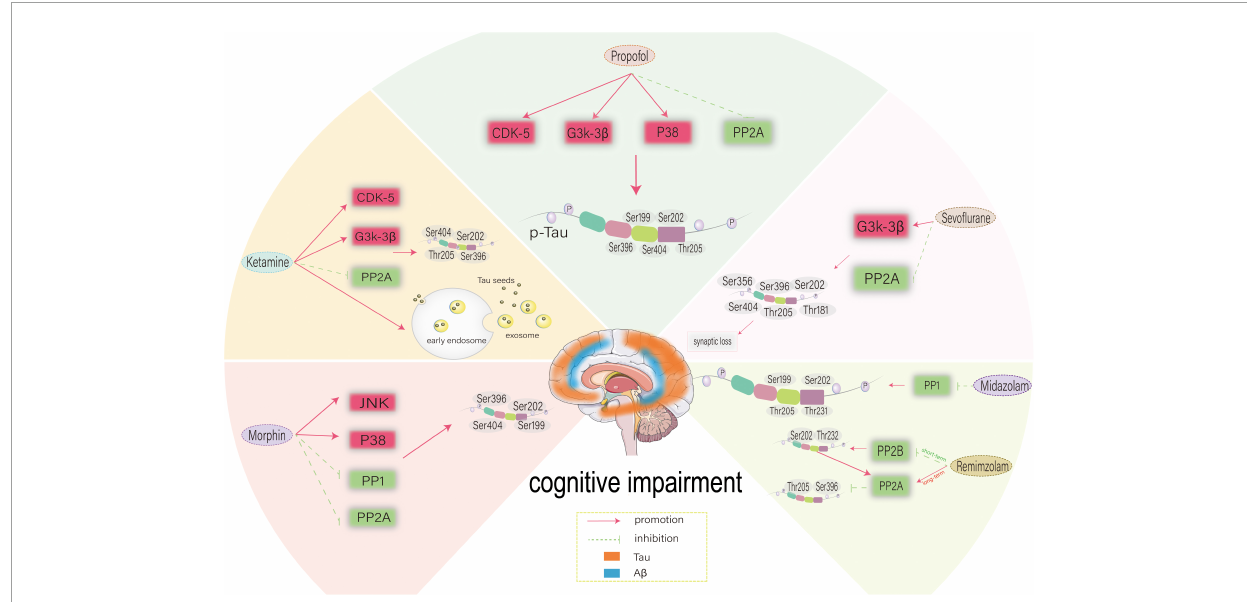
FIGURE3 Possible mechanism of different anesthetic drugs-induced-Tau phosphorylation at different sites. CDK5, cyclin-dependent kinase 5; GSK-3 β , glycogen synthase kinase-3 β ; PP2A, protein phosphatase 2A; PP2B, protein phosphatase 2B; PP1, protein phosphatase 1; CDK5, cyclin-dependent kinase 5; JNK, c-Jun NH2-terminal